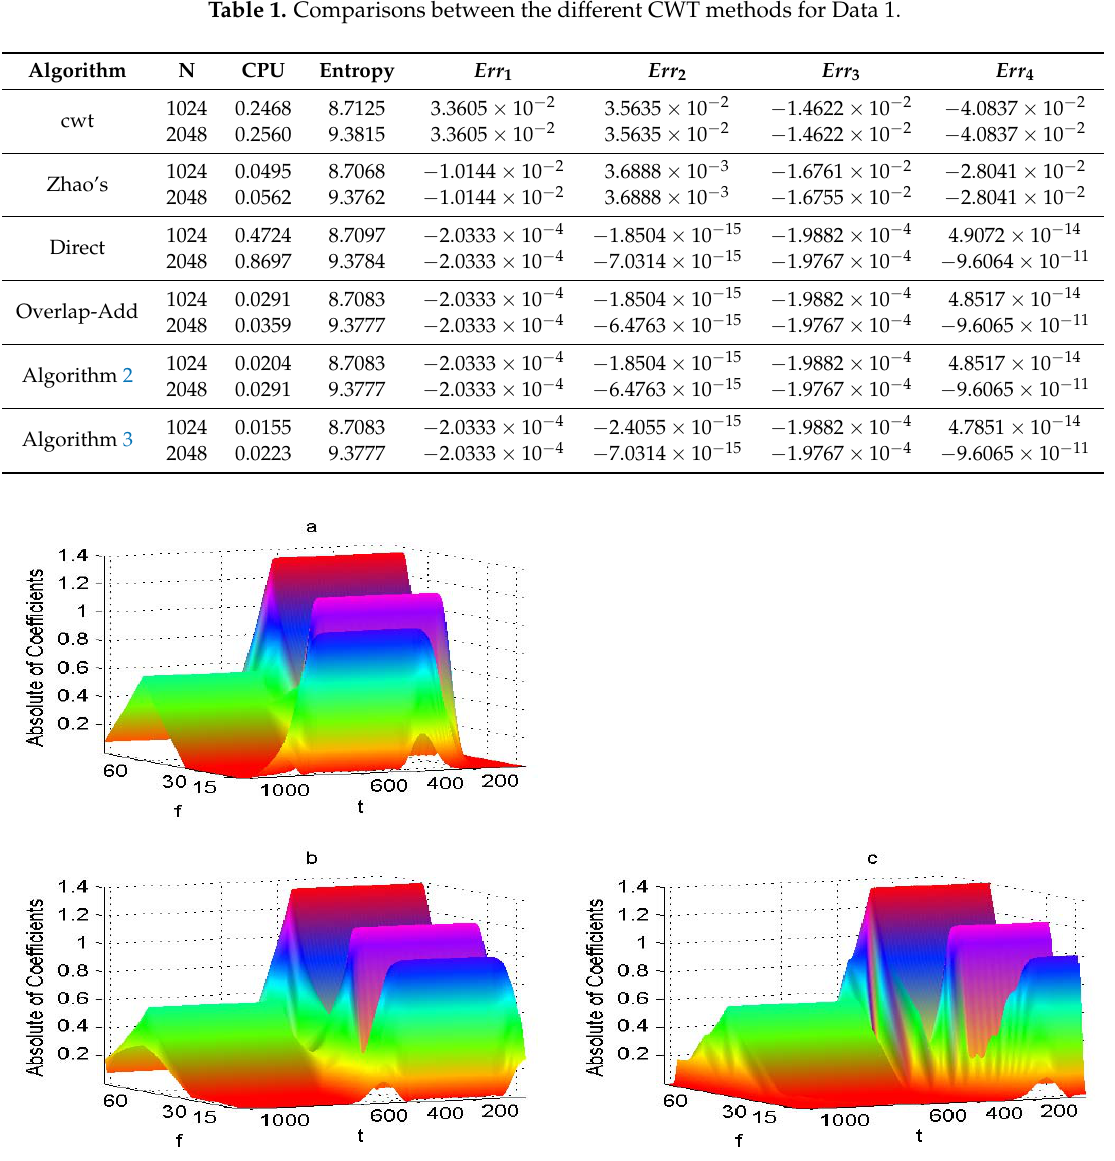
Figure 2. Figure 2 is computed by using the case 1 of Algorithm 3. The wavelet coefficients of ( b ) can exactly characterize the time-frequency local properties of data of ( a ). At the same time, ( a , c ) fail to do